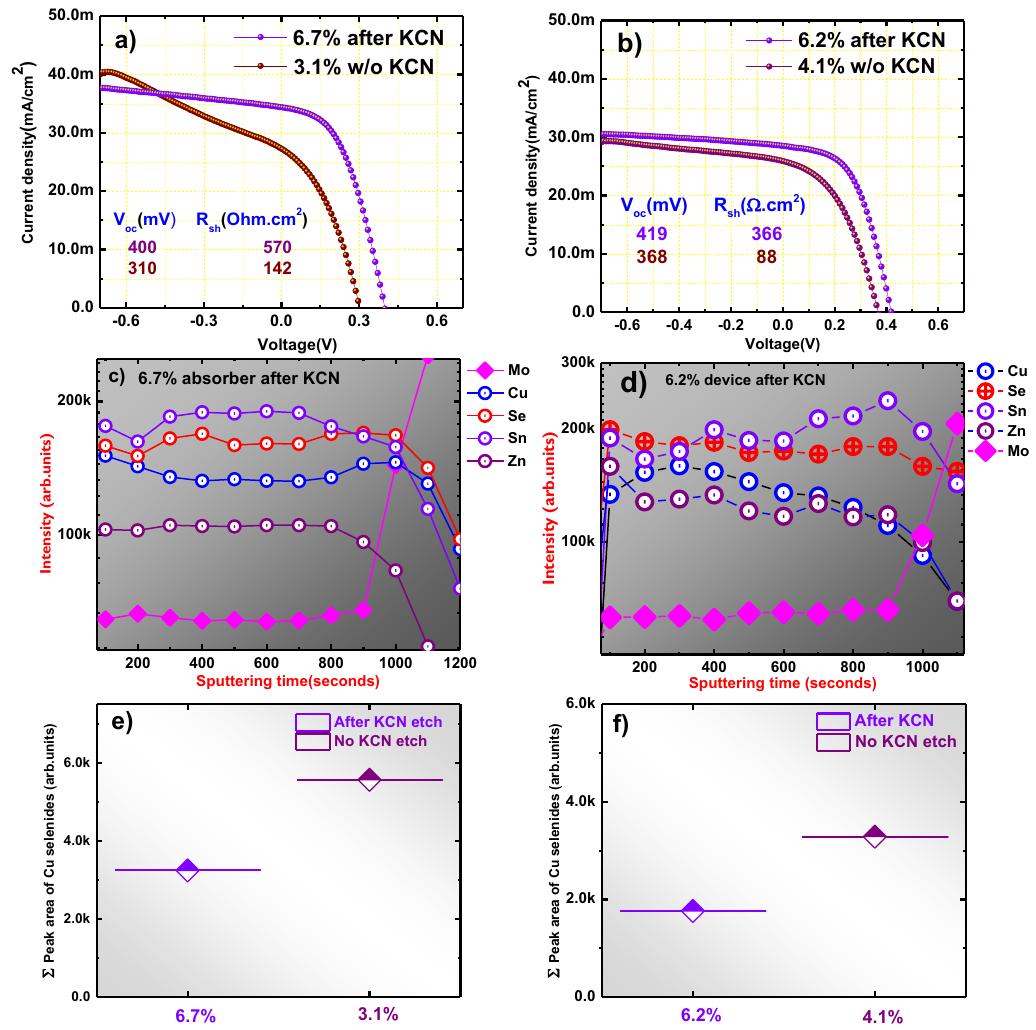
Fig. 4. (a) and (b) Illuminated I - V curves of CZTSe solar cells fabricated with and without KCN etching step. (c) and (d) AES depth profiling of the same cells. (e) and (f) graphical schematic showing the amount of Cu selenide secondary phase in the 2 solar cells.